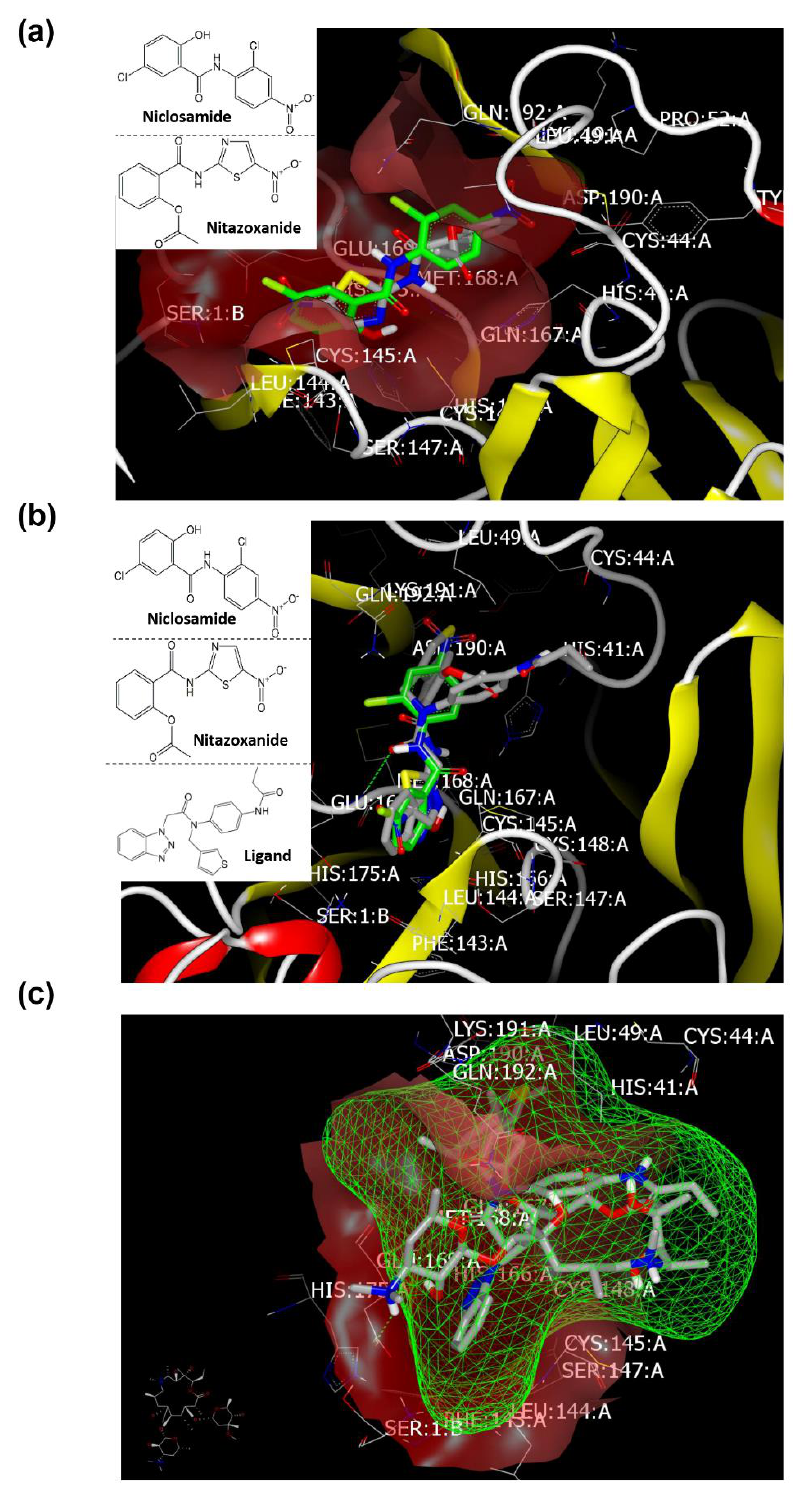
Figure 6. Visual representation by VIDA for docking with the main protease of MERS-CoV (PDB ID: 4ylu). ( a ) Niclosamide (green color) and Nitazoxanide (grey color) overlay each other, ( b ) ligand (grey color), Niclosamide (green color), and Nitazoxanide (grey color with yellow sulfur atom color) inside the inner grid for validation, and ( c ) Azithromycin with amino outside the